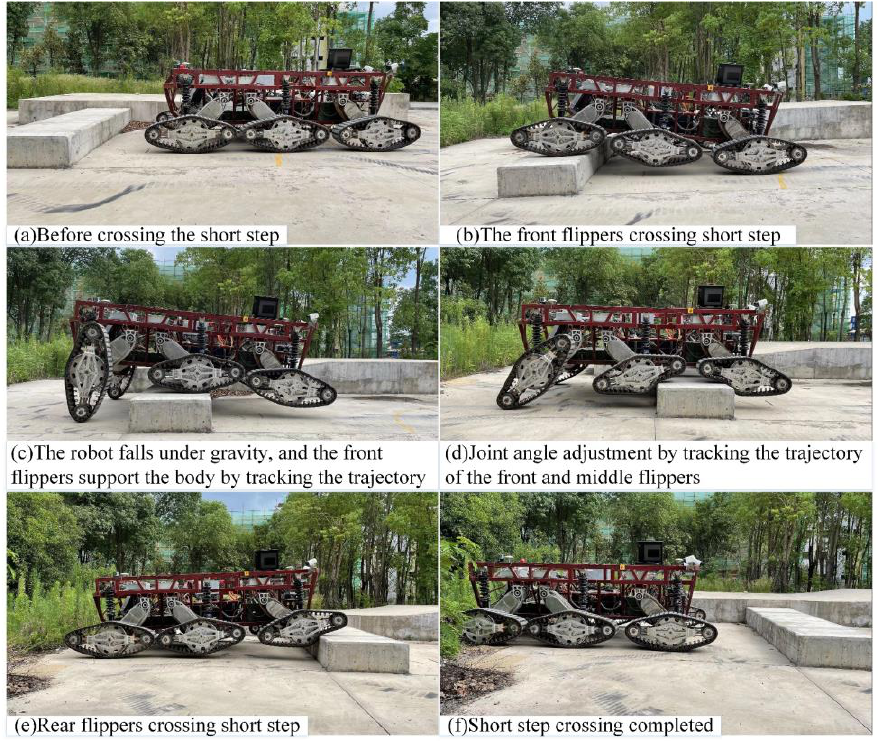
Figure 14. Snapshot of short step traversal.